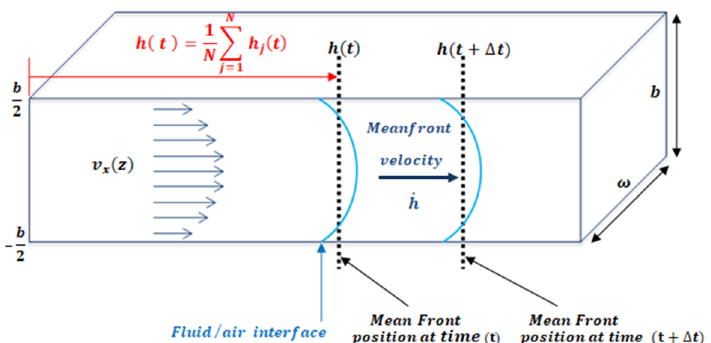
Figure 2. The velocity v x ( z ) is the x component of velocity inside the microfluidic channel as a function of height ( z ) ; h ( t ) indicates the mean position of the fluid front. The channel dimensions satisfy the relation b /ω ≪ 1 .